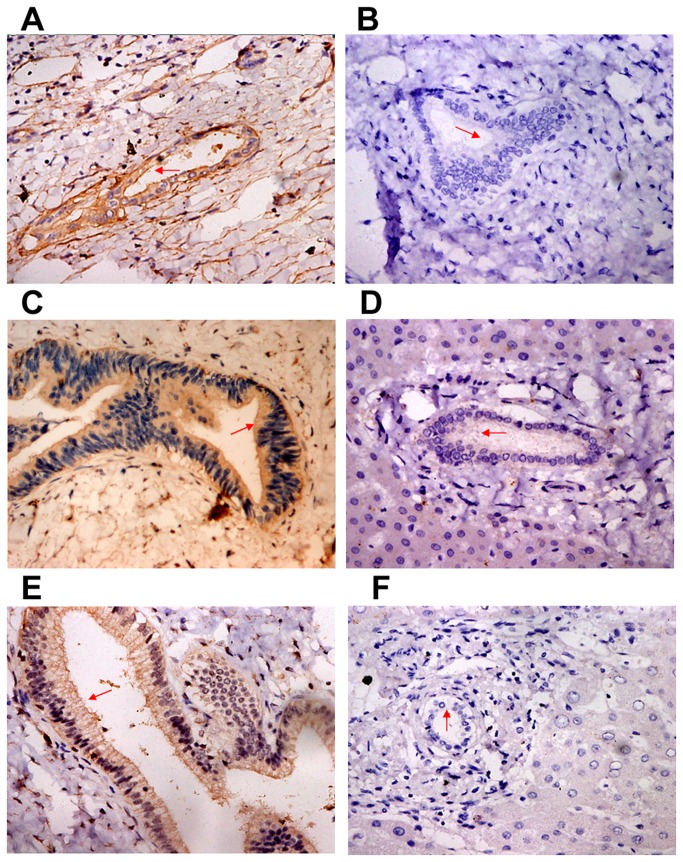
Immunohistochemistry.VEGFR-2, Gab1 and MMP-9 expression in hilar cholangiocarcinoma tissues and biliary duct tissues with chronic inflammation were detected using immunohistochemical methods. Results were expressed as mean OD. Comparison of the mean OD showed that VEGFR-2, Gab1 and MMP-9 expression levels in hilar cholangiocarcinoma tissues (A, C, E) were significantly higher than those in biliary duct tissues with chronic inflammation (B, D, F) (**P<0.01).